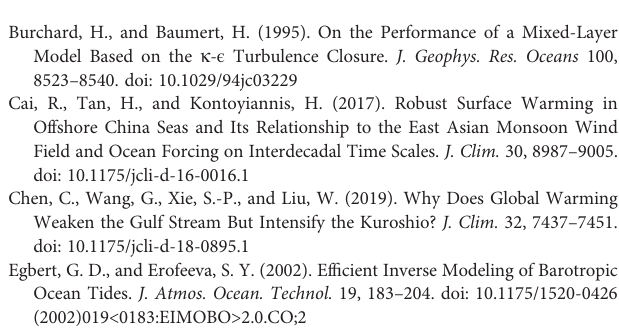
Supplementary Figure 1 | The same as, but for the composite for the slow SST evolution years. Supplementary Figure 2 | The same as, but for the composite for the rapid SST evolution years. Supplementary Figure 3 | The same as, but for the PM2.5 concentration in Beijing, Shanghai, and